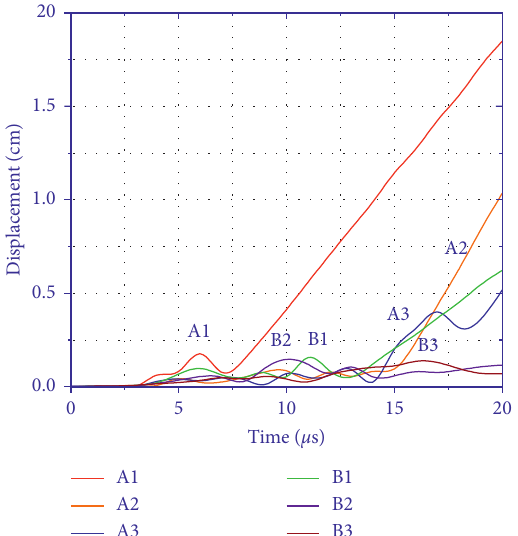
Figure 25: Joint displacement curve of anhydrous bag-charge blasting.